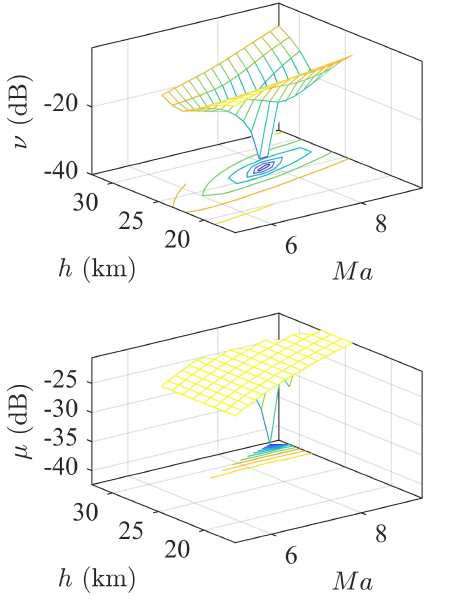
Figure 8. NCSM and gap metric of ascent tracking at Mach 7.8, h = 26,495